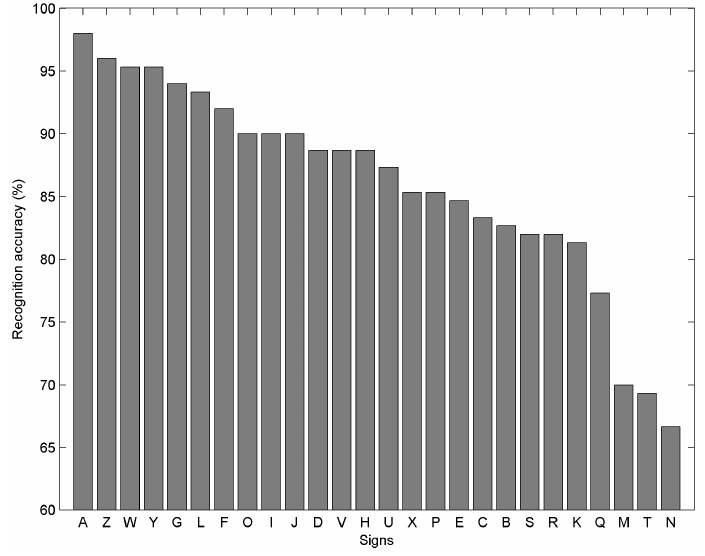
Figure 7. Accuracy of ASL Gesture Recognition.